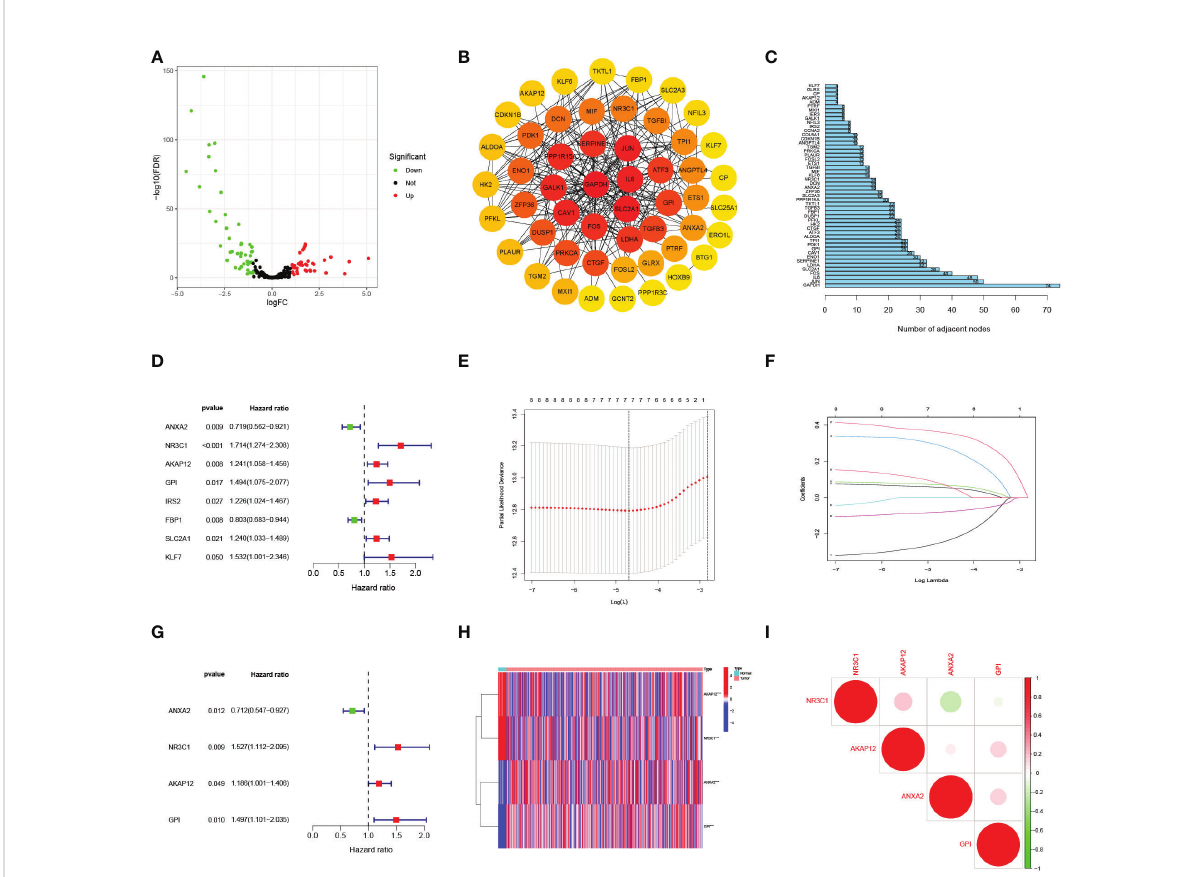
FIGURE 2 Selecting hypoxia-associated key core genes and constructing the model by Univariate, Lasso, and Multivariate Cox Analysis. (A) Volcano map of differential hypoxia-associated genes, absolute log2-fold change (FC) > 1, and adjusted p value < 0.05 were used as screening criteria for differential genes. (B) Protein-protein interaction network containing these genes. (C) The top 50 genes were selected based on the number of nodes. (D) Univariate Cox regression analysis identi fi ed candidate genes with the p -value < 0.05. (E, F) Establishing a hypoxia prognostic model by LASSO regression analysis. (G) Multivariate Cox regression analysis of hypoxia-related genes. (H) Heatmap of differential hypoxia-associated genes in normal samples and endometrial cancer. (I) Correlations between the genes included in the risk model. *** represents a p value <